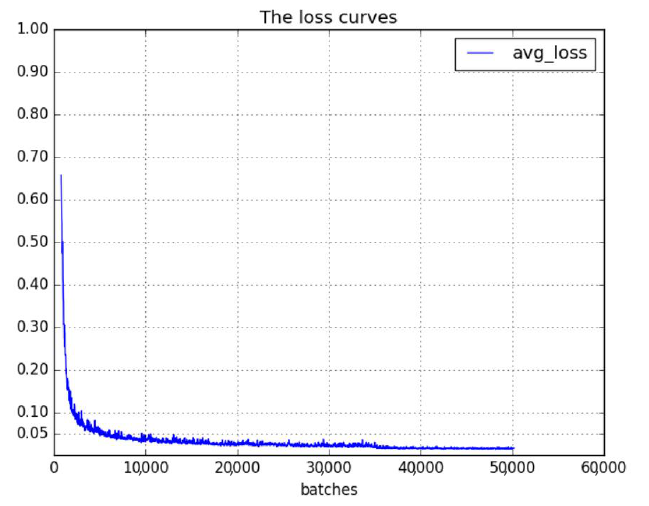
Figure 8. The loss